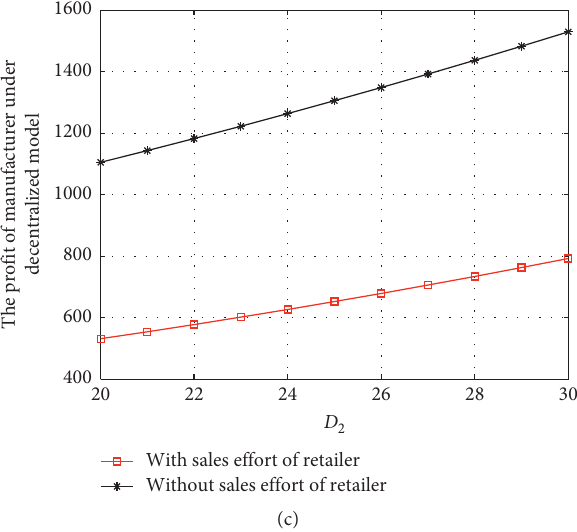
Figure 8: The optimal profit with and without sales effort under the decentralized model.